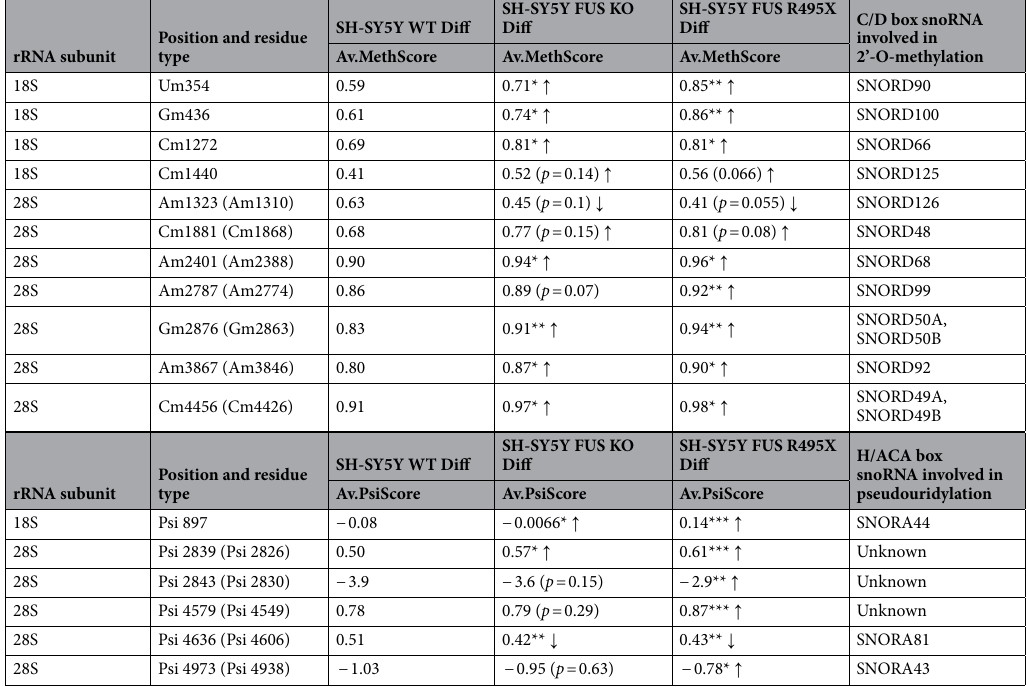
Table 3. 2’-O-methylation and pseudouridylation positions changed in 18S and 28S ribosomal RNAs in SH-SY5Y WT, FUS KO and FUS R495X cells differentiated (Diff) for 10 days using retinoic acid. The MethScores and the PsiScores represent the average of three biological replicates and describe a fraction of molecules methylated and pseudouridylated at a given position, respectively. The old nomenclature is shown in brackets. Arrows depict the direction of modification changes in FUS KO and FUS R495X cells relative to WT cells. Negative values mean that these residues are not protected against hydrazine / aniline treatment, hence they are not pseudouridylated. P values were calculated using paired Student’s t -test, and the statistical significance is represented as fallows: * p ≤ 0.05; ** p ≤ 0.01; *** p ≤